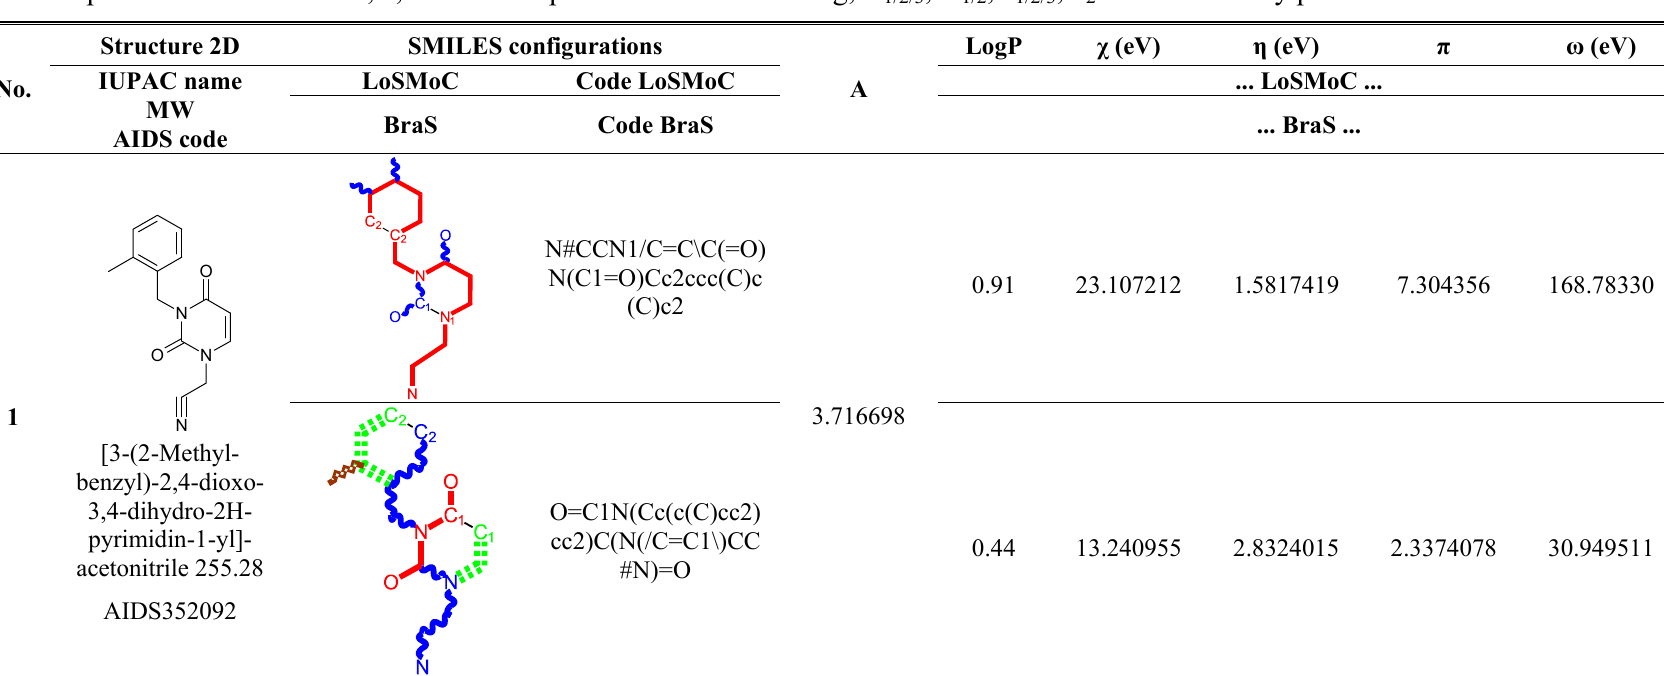
Table 1. Working molecules (IUPAC name and molecular weight MW are indicated ) and their corresponding SMILES topology, i.e. the longest SMILES molecular chain (LoSMoC) as upper entry and the Branching SMILES (BraS) as down entry, for each pyrimidine structure (1/EC ) employed from half maximal effective concentration (EC , μ M) antiviral activity of considered, along the common activity A = log 10 50 50 1,3-disubstituted uracils against human immunodeficiency virus (HIV-1) [69], with AIDS code indicated [84], respectively. The solubility parameter of lipophilicity (LogP), and the chemical reactivity parameters such as electronegativity ( χ ) and chemical hardness ( η ), chemical power ( π ) and electrophilicity ( ω ) are considered within the semiempirical (AM1) framework (Polak-Ribiere conjugate gradient algorithm and geometry optimization till the root mean square RMS gradient was equal to or less than 0.01 kcal/Åmol) as provided by the Hyperchem 7.01 computational environment [140], while the chemical reactivity values were computed in terms of HOMO and LUMO from equations (14) and (15)—see text and Table 2, (7) and (10), respectively. SMILES legend